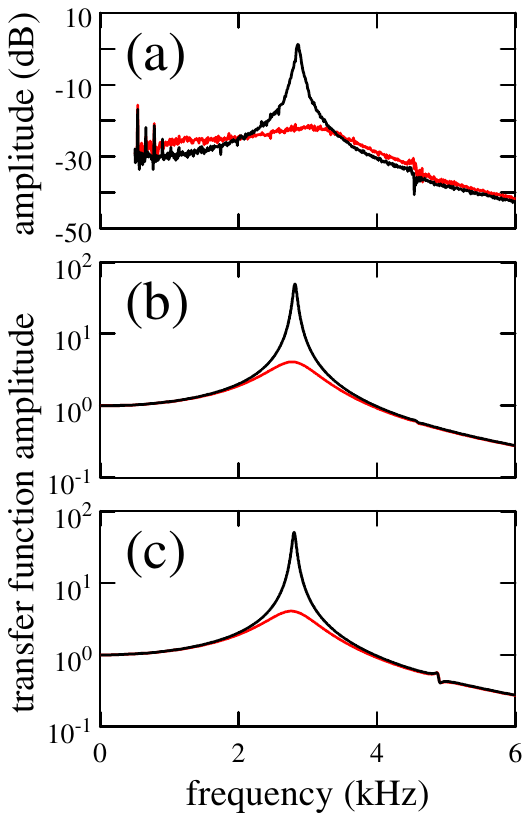
FIG. 3. (Color) Operation with passive harmonic-cavity voltage equaling 41% of that required for optimal bunch lengthening. Black curves: phase feedback off. Red curves: phase feedback on. (a) Experimental measurement of the transfer function amplitude. (b) Transfer function amplitude calculated with the beam energy spread equaling its natural value. (c) Transfer function amplitude calculated with the beam energy spread equaling 3 times its natural